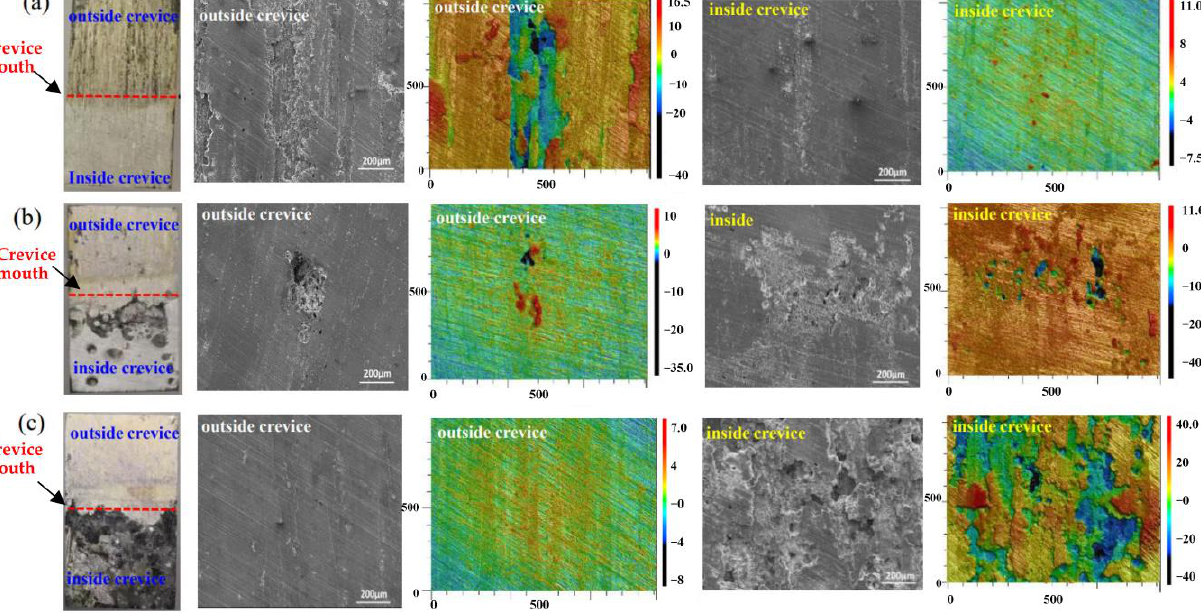
Figure 8. The macro morphology, micro morphology, and 3D depth profiles of specimens inside and outside the crevice in solutions with different concentrations of NaNO 3 after corrosion for 24 h.